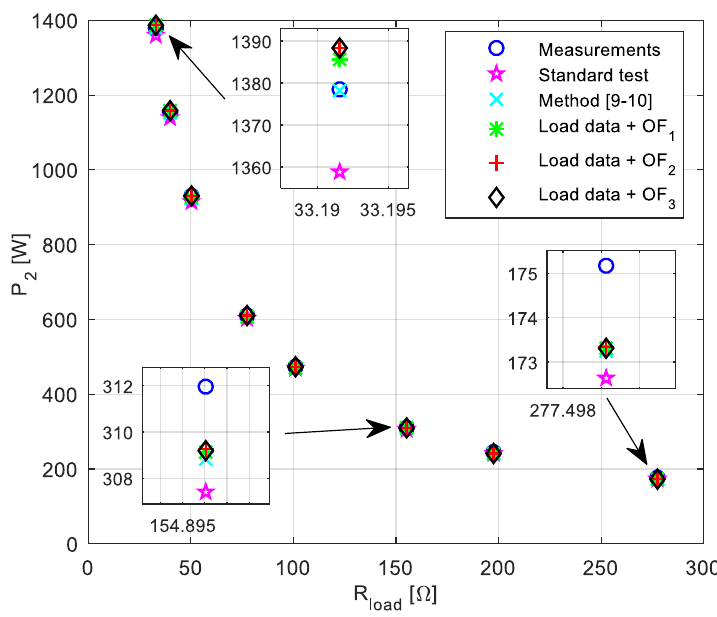
Figure 8. Output power versus load resistance referred to the primary side characteristics.